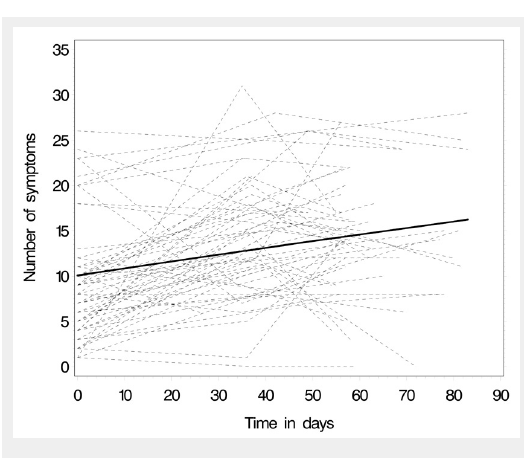
Predicted trend of number of symptoms over the three measurement points: thin lines represent patients’ individual trajectories, the thick line the average group